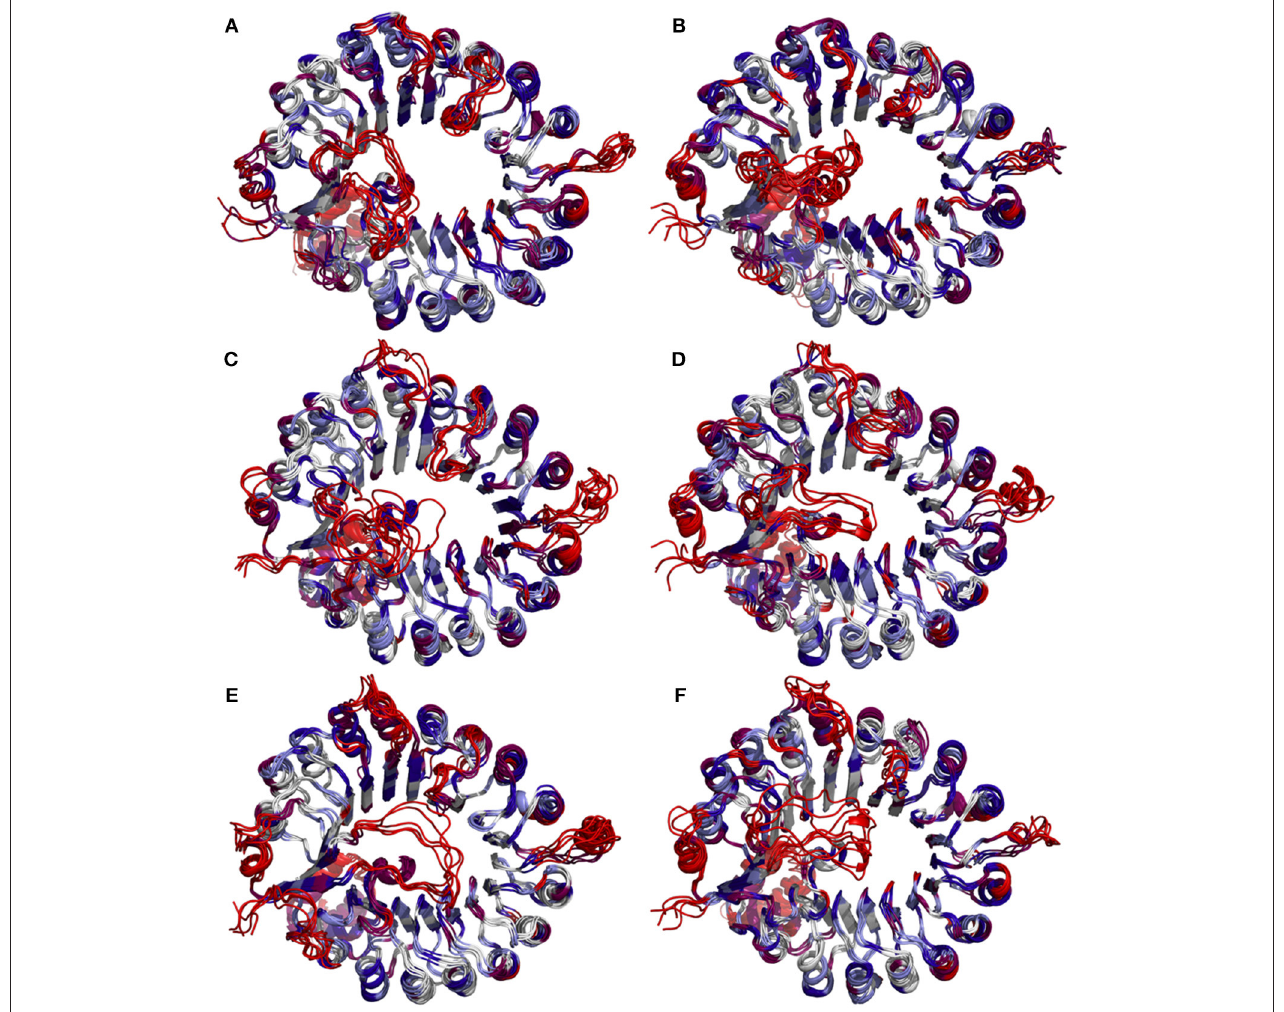
FIGURE 6 | Snapshots of COI1 structures from MD trajectories. The color is coded by the RMSF value, with blue being the lowest fluctuations to light blue to white to magenta to red being the highest fluctuations. (A) system 1, COI1 + ASK1; (B) system 2, COI1 + ASK1 + 1,5-InsP 8 ; (C) system 3, COI1 + ASK1 + 1,5-InsP 8 + JA-Ile; (D) system 4, COI1 + ASK1 + JAZ1 + JA-Ile; (E) system 5, COI1 + ASK1 + JAZ1 + 1,5-InsP 8 ; (F) system 6, COI1 + ASK1 + JAZ1 + 1,5-InsP 8 +